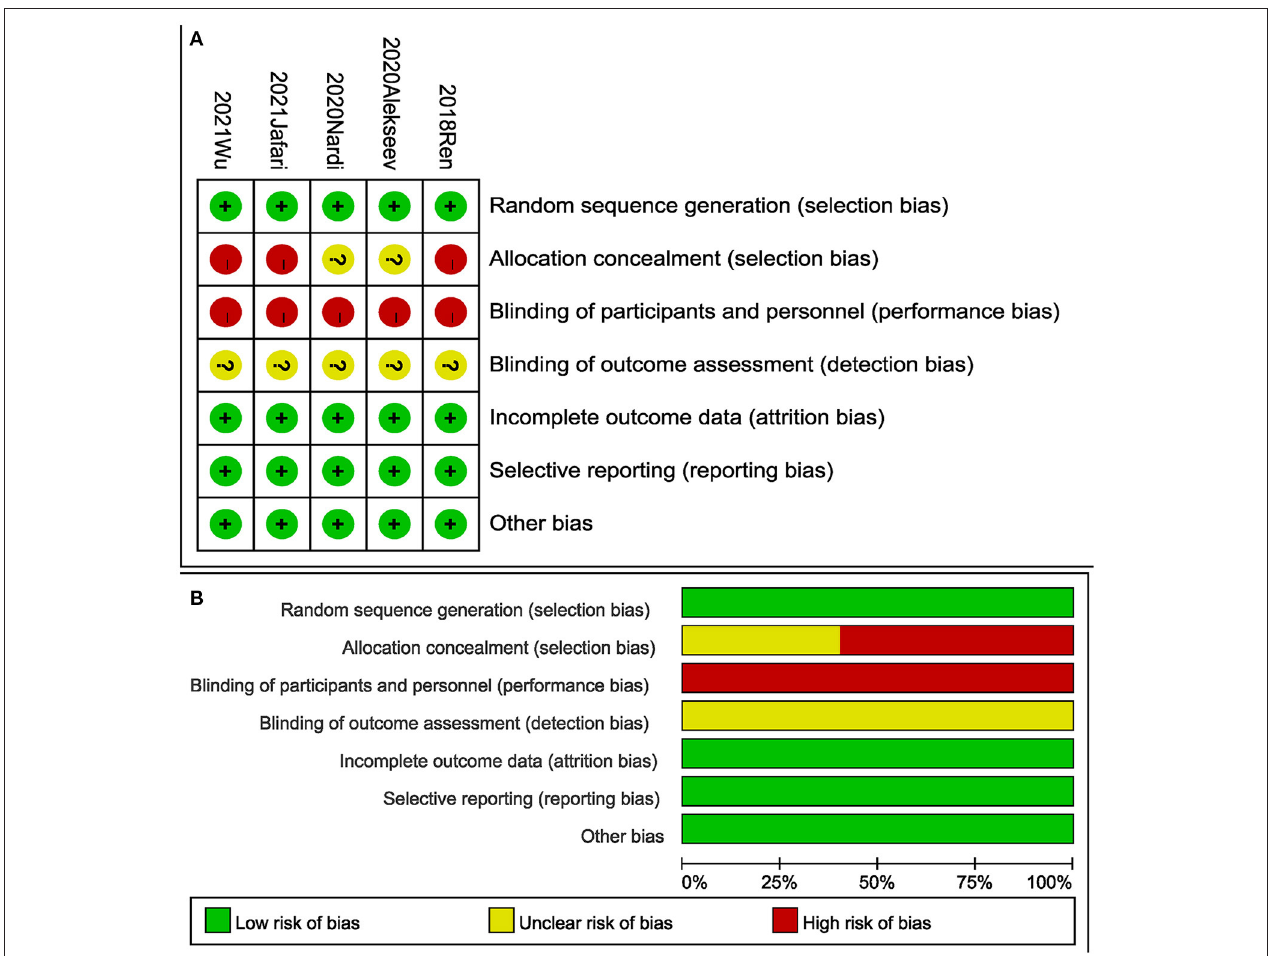
FIGURE 2 | Risk of bias for each included study. (A) Risk of bias summary. (B) Risk of bias graph.